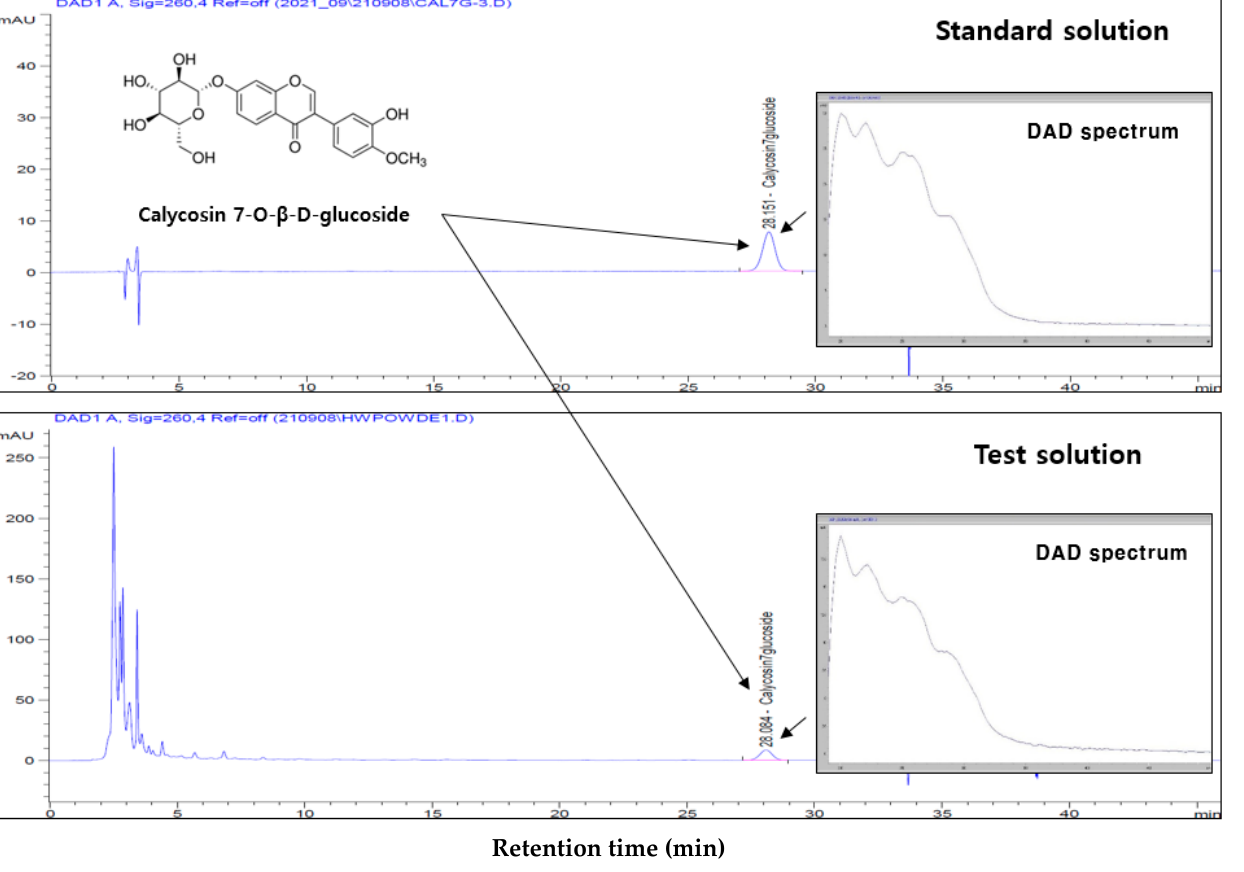
Figure 1. HPLC chromatogram of calycosin 7-O- β -D-glucoside in Astragali Radix extract.